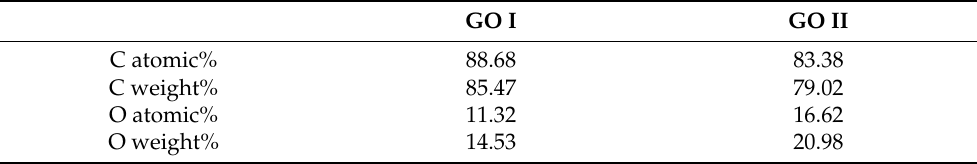
Table 3. The content of carbon and oxygen in GO I and GO II determined by EDX measurements.